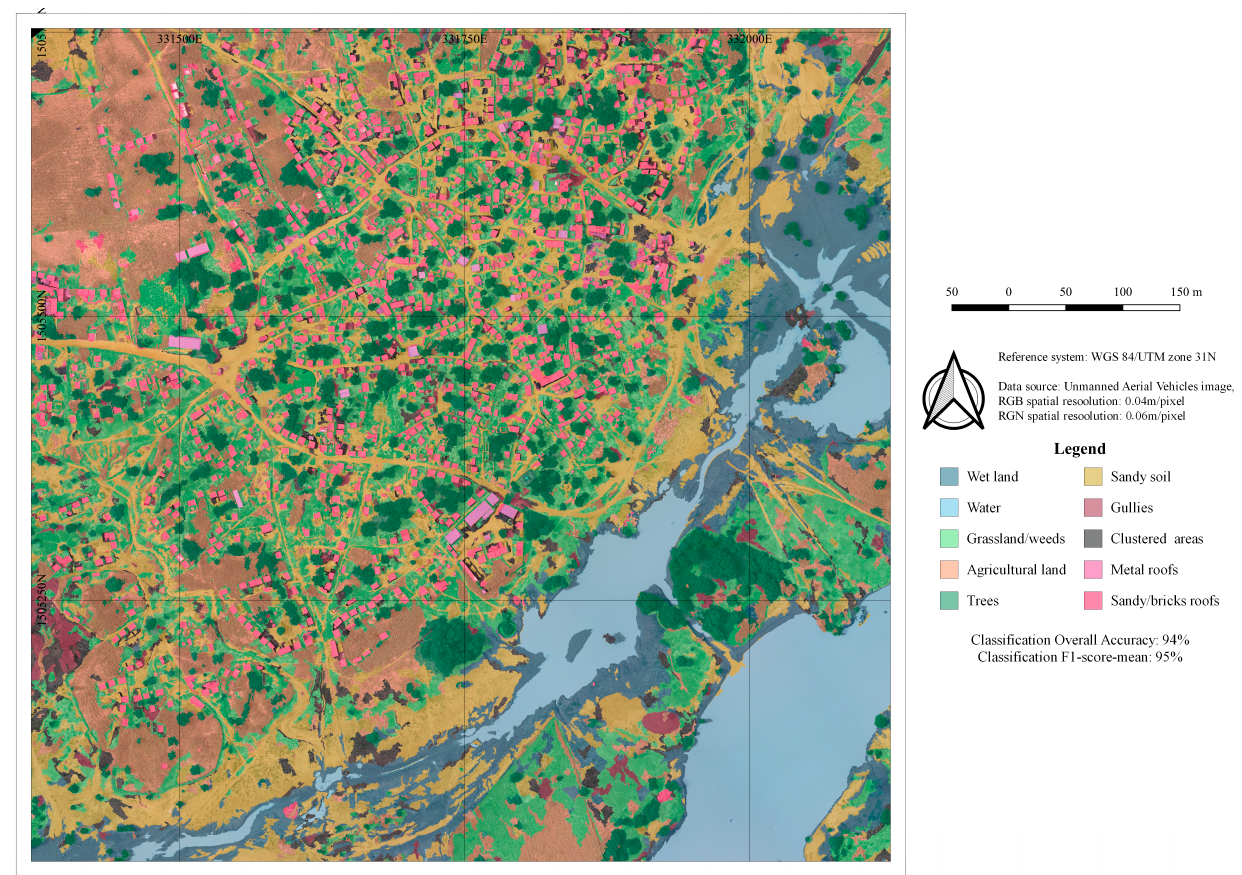
Figure 9. LC map of Tour è